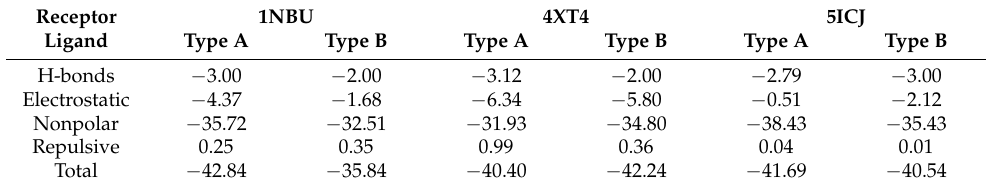
Table 3. Energies of interactions for the 2-amino-8-oxa-1,5-diazaspiro[4.5]dec-1-ene-5-ammonium complexes with receptors